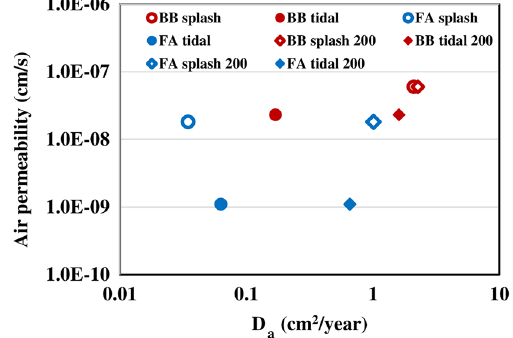
Fig. 9 Air permeability versus chloride diffusion coefficient by salt immersion test (D a ) and chloride diffusion coeffi- cient of marine exposed concrete (D c ) for exposed concrete.